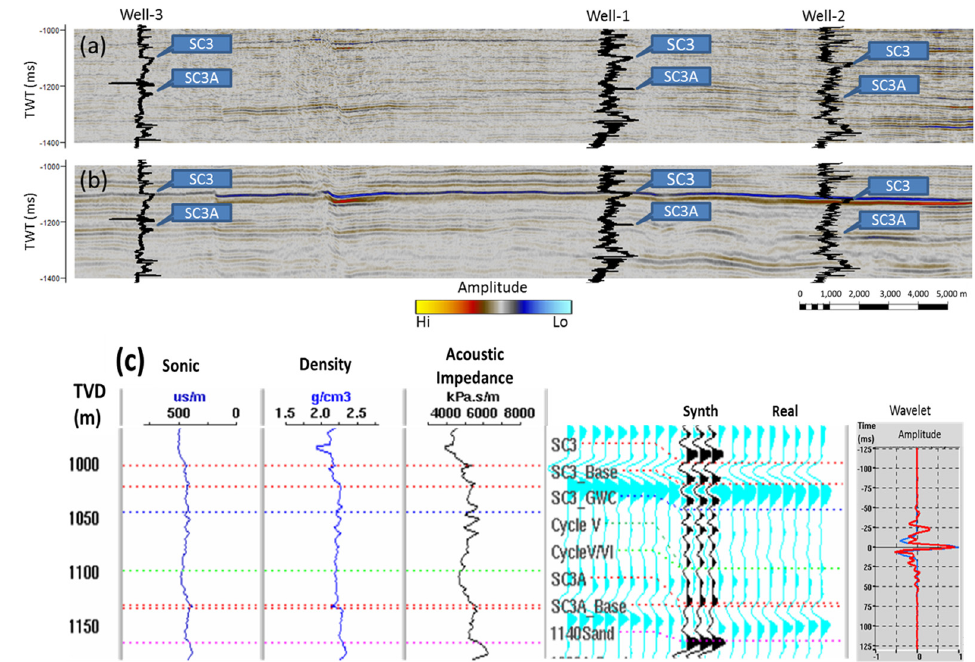
Figure 3. Seismic data input and seismic-to-well tie. Near ( a ) and Far ( b ) Seismic section of the study field showing strong AVO anomaly. Black curves are Gamma Ray logs from (left to right) Well three, Well one and Well two. The markers show thick upper reservoir, SC3, and thin lower reservoir, SC3A at each wells site. ( c ) Well one seismic to well tie. Red curve is extracted wavelet; blue is a 45 Hz Ricker wavelet (Courtesy of Petronas Carigali).